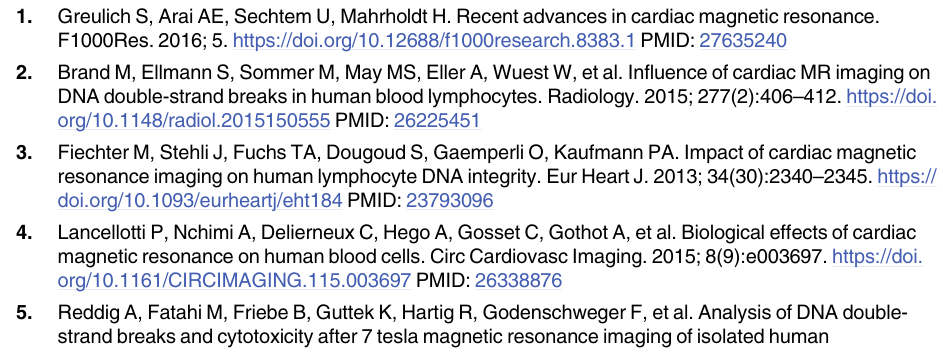
S1 Fig. Representative peripheral blood mononuclear cell staining of 53BP1 and γ H2AX. Nuclei stained blue by DAPI are shown. White foci within the nuclei are 53BP1 or γ H2AX foci as visualized by anti-53BP1 or anti- γ H2AX antibodies as described in the Methods. These foci were detected by Exogen’s automated foci quantification algorithm as highlighted in